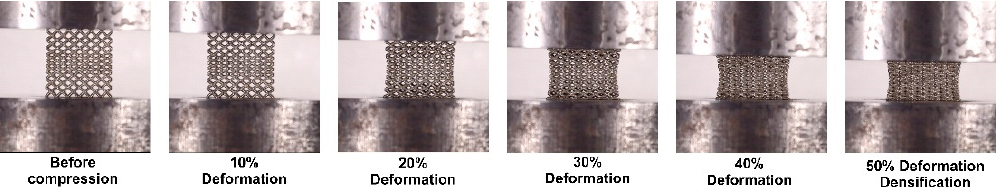
Figure 13. The main stages of the deformation process of a lattice specimen with a gradually increasing topology.